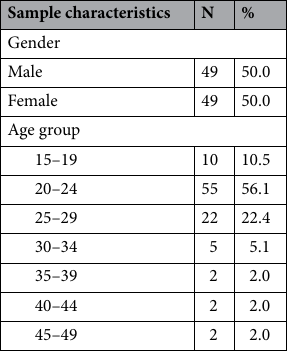
Table 1. Distribution of study